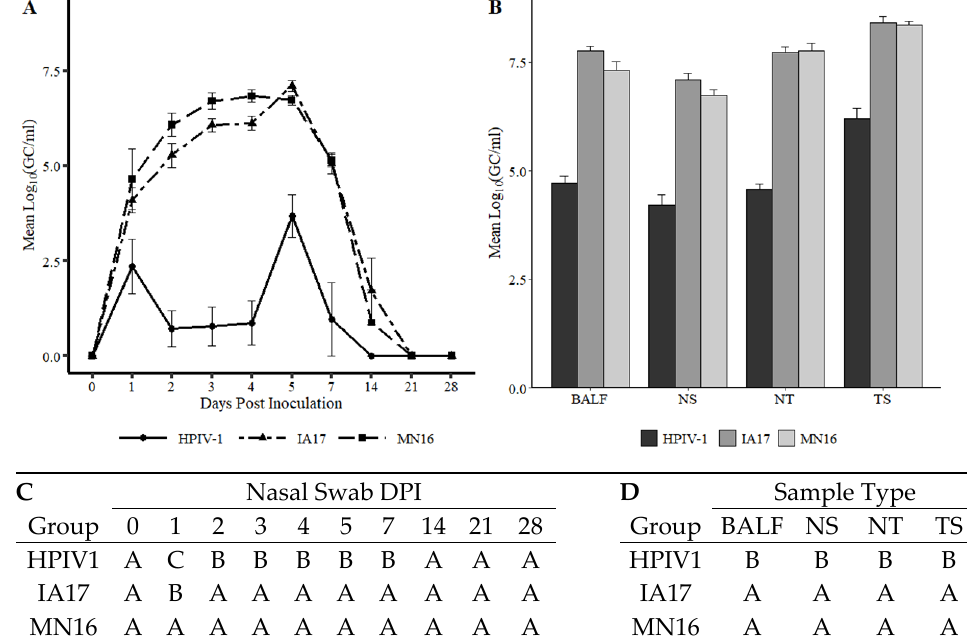
Figure 3 . Detection of HIPV1, IA17, or MN16 viral nucleic acid from experimental specimens by RT-qPCR. ( A ) Mean HPIV1, IA17, and MN16 GC/mL detected in antemortem NS homogenate and standard error of the mean (SEM) error bars. ( B ) Mean HPIV1, IA17, and MN16 GC/mL detected in BALF, NS, NT and TS necropsy sample homogenates and SEM error bars. ( C ) Connecting letters report comparing nasal swab GC/mL at each DPI is provided to indicate significance at p < 0.05. Groups with different letters within a column are significantly different. A Tukey–Kramer adjustment for multiple comparisons was applied to correct for family-wise error rate. ( D ) Connecting letters report comparing BALF, NS, NT and TS GC/mL collected at necropsy is provided to indicate significance at p < 0.05. Groups with different letters within a column are significantly different. A Tukey – Kramer adjustment for multiple comparisons was applied to correct for family-wise error rate.